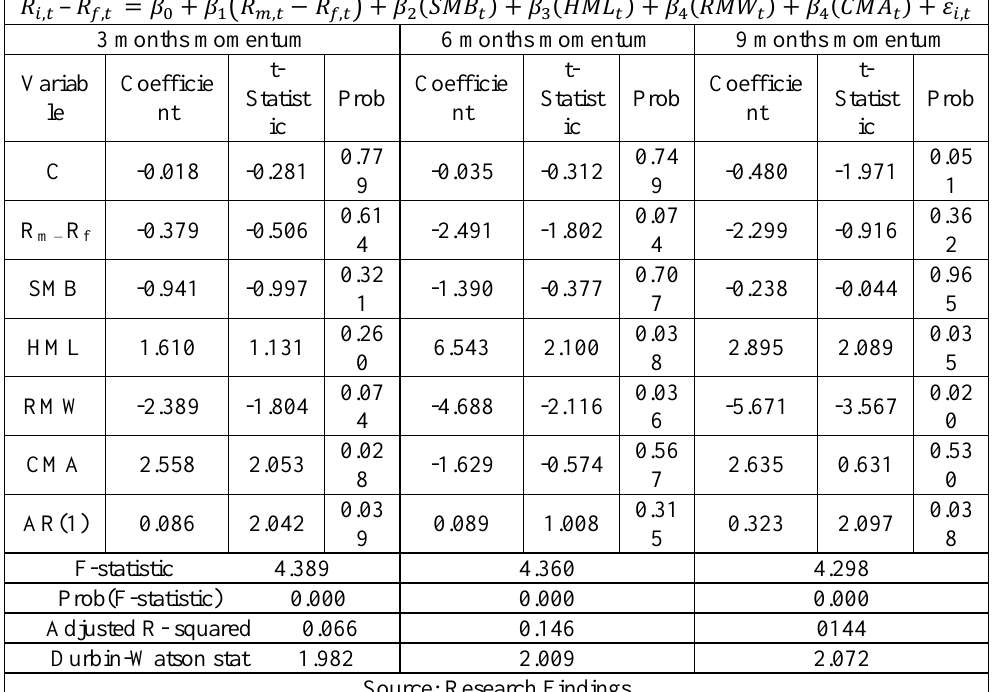
Table 10. Results of testing the fourth research hypothesis with low liquidity using